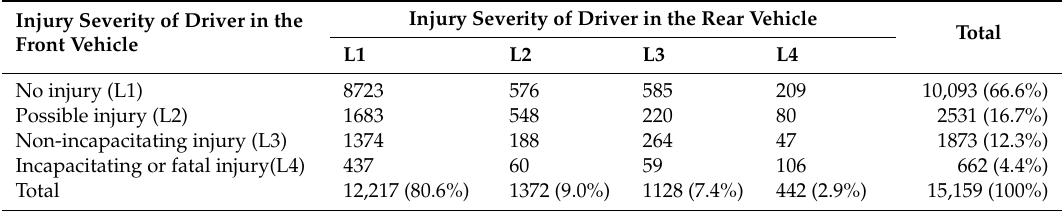
Table 1. Summary of injury severity for rear-end crash-involved drivers.